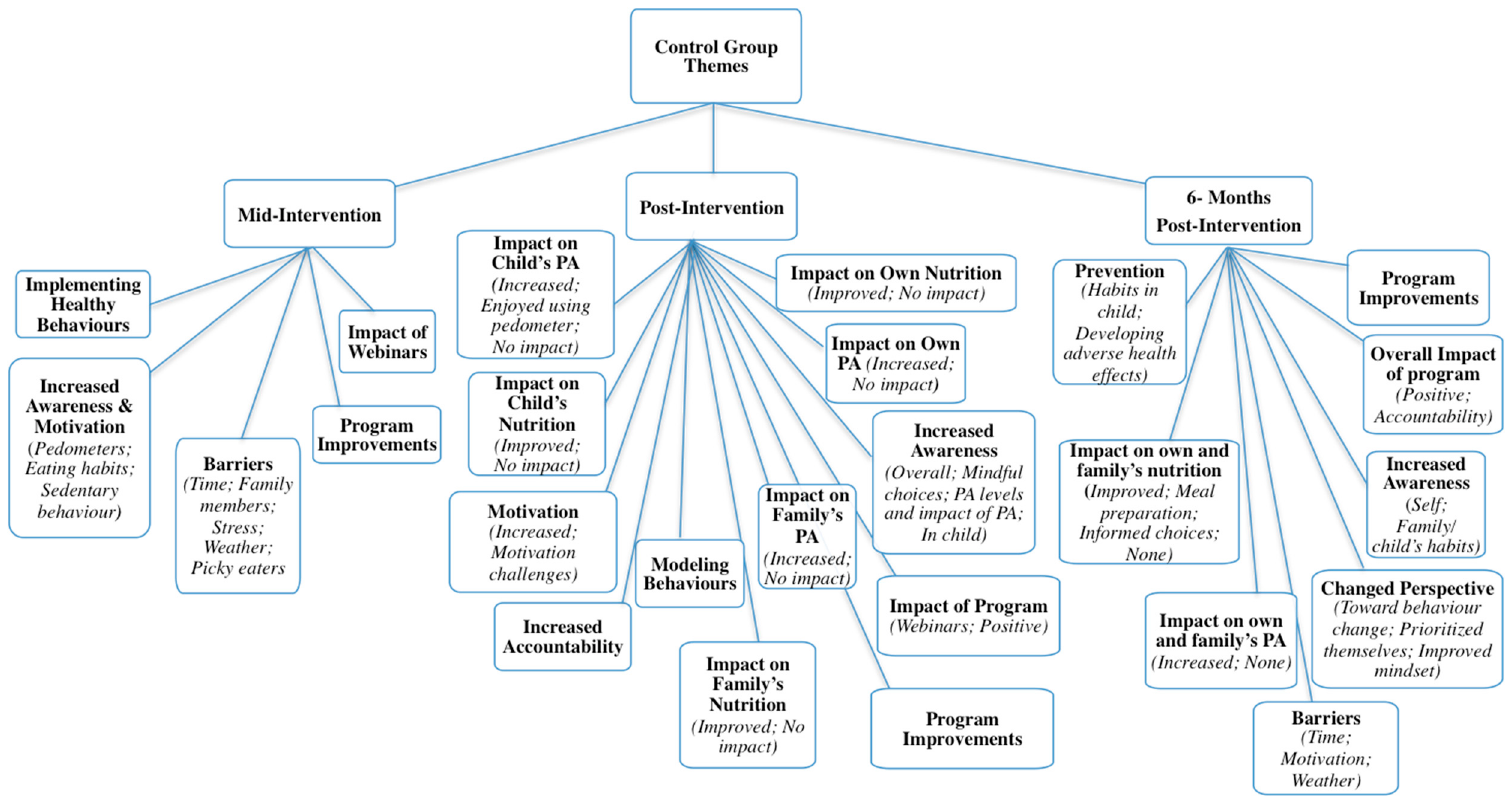
Figure 4. Control themes from all relevant time points.